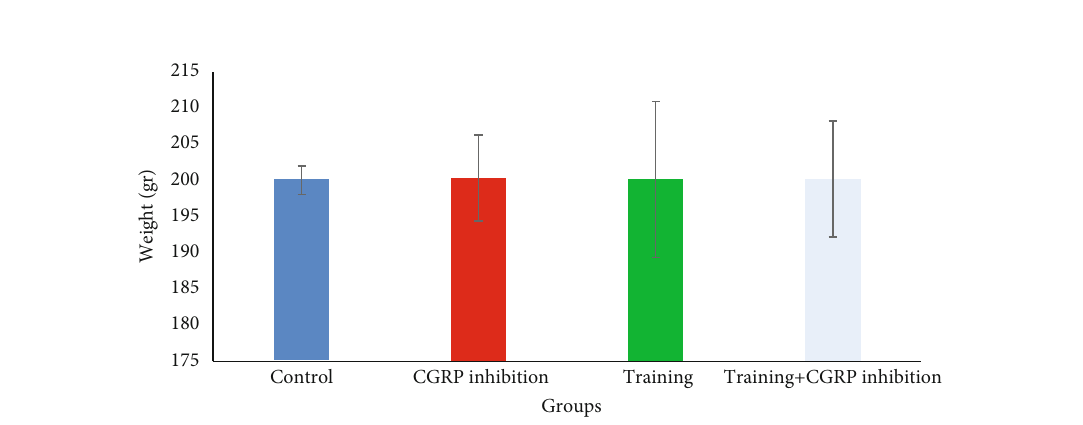
Figure 3: Weights ( mean ± SD ) of rats in